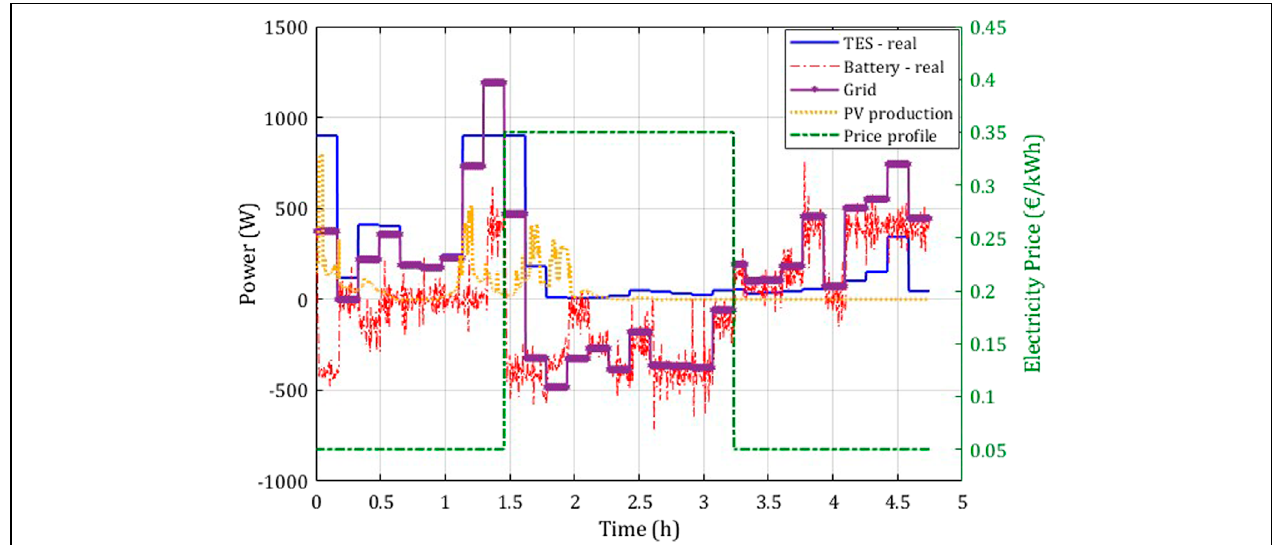
FIGURE 6 | Total power distribution among all storages, generators, and utility grid.